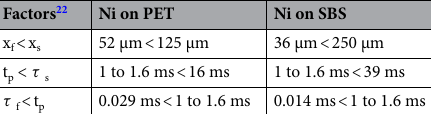
Table 2. Three transient curing